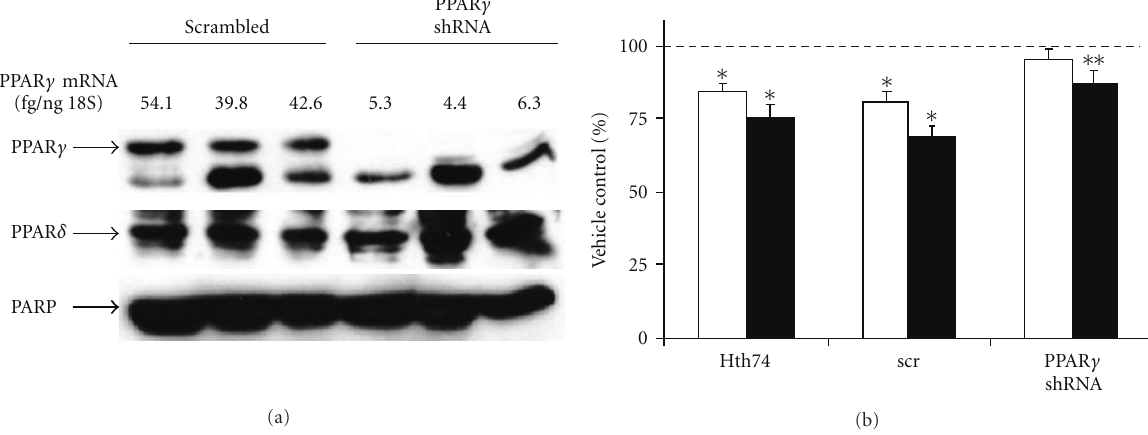
Figure 3: PPAR γ shRNA decreases PPAR γ mRNA and protein levels and partially abrogates growth inhibition by Rosi. (a) 40 μ g of nuclear extract protein from HTh74 cells transduced with either scrambled or PPAR γ -specific shRNA (3 independent transductions) was separated on a 10% SDS-PAGE gel, transferred to PVD, and probed with PPAR γ antibodies (sc-7196) as described in Figure 2(a). The blot was stripped and reprobed with antibodies to PPAR δ (sc-7197). PARP was quantitated as a loading control. Shown above the protein blot are PPAR γ RNA levels measured by qRT-PCR as in Figure 2(b). (b) Viable HTh74 cells either untransduced or transduced with scrambled (scr) or PPAR γ shRNA were counted after 3 days treatment with 1 μ M (white bars) and 10 μ M Rosi (black bars). The DMSO vehicle represented by the dotted line is set to 100%. Shown is the % of vehicle control for each cell type (average of 3 di ff erent expts. ± SEM. ∗ : significantly lower than vehicle, P < 0 . 05; ∗∗ : significantly lower than vehicle but higher than scr (10 μ M), P < 0 .